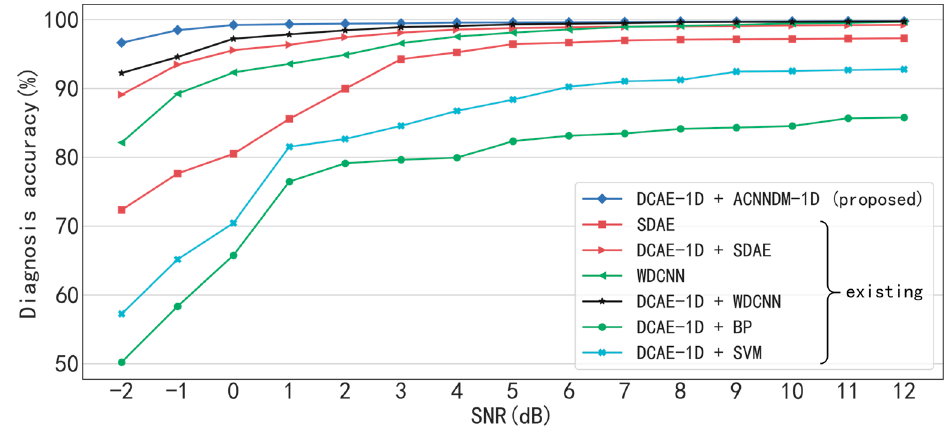
Figure 12. The comparison between the proposed method and existing models.